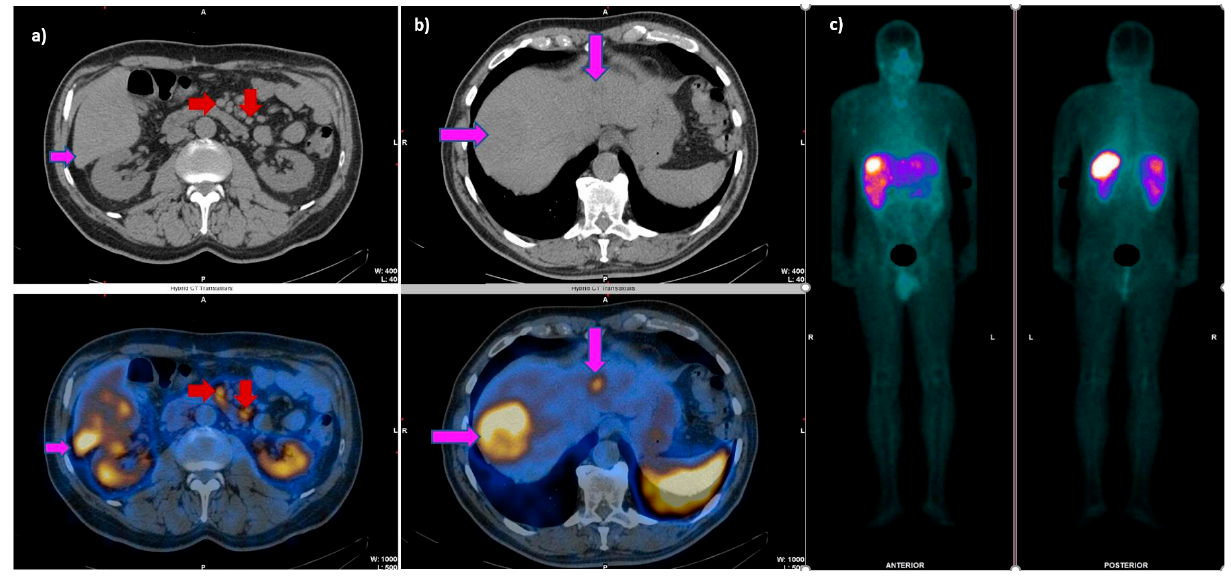
Figure 2. A 64-year-old male patient diagnosed with an ileal neuroendocrine tumor (NET G1), excized in 2021. The present SRS shows increased uptake corresponding to mesenteric lymphadenopathy (( a ), red arrows) and multiple liver metastases (pink arrows), the most prominent one situated in the VIII hepatic segment ( b ), visible on the WB planar scan as well ( c